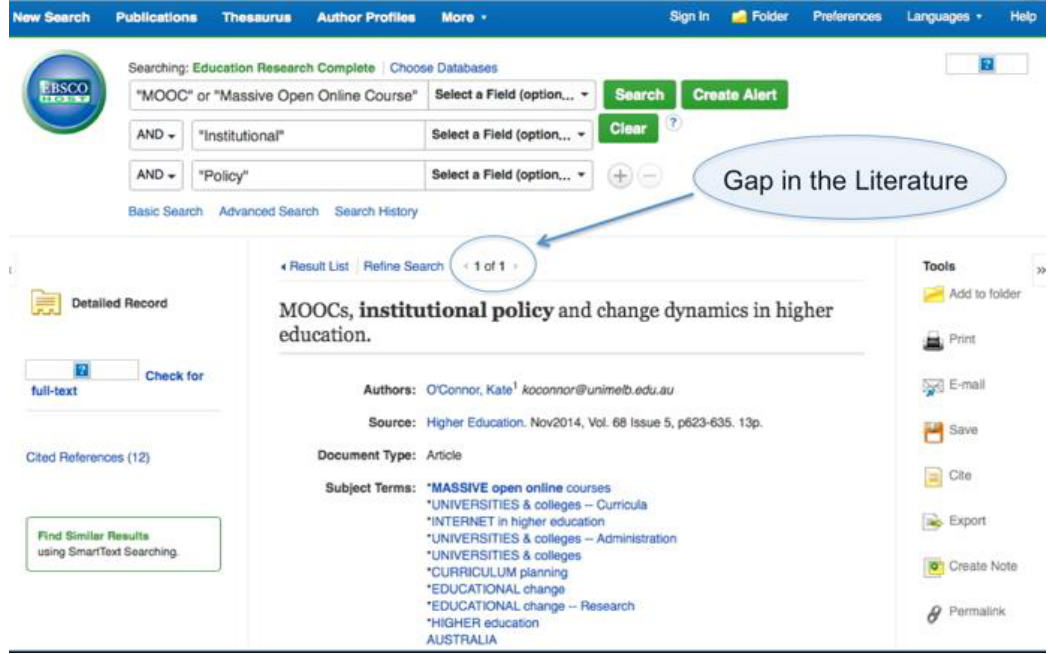
Figure 1. Results of EBSCO search on MOOC policy drivers Why MOOCs at